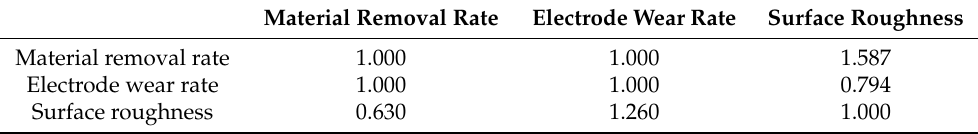
Table 10. The judgement matrix of group integration for performance characteristics.